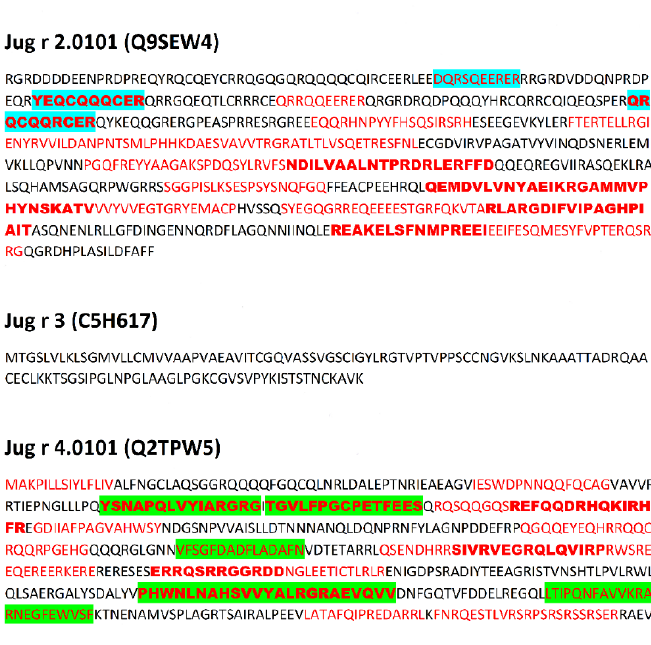
Figure 3. Sequences of allergens from Juglans regia . Location of epitopes is indicated using red font. Green background indicates epitopes with highest ∑ A (range 1.6000–2.1000), blue background indicates epitopes with lowest ∑ A (range 0.1000–0.5999). Bold font indicates epitopes and their fragments occurring both in Carya illinoinensis and Juglans regia proteins .